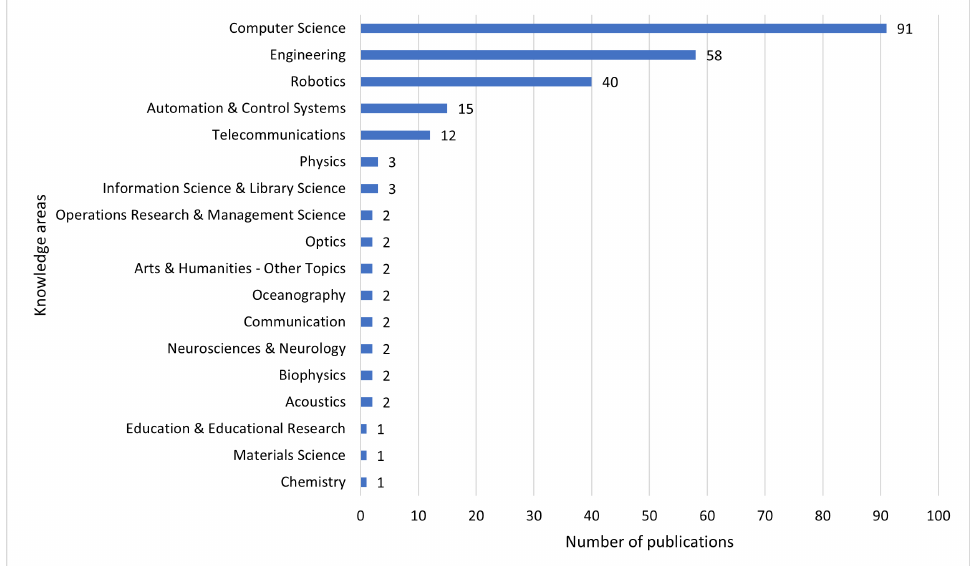
repeated are: augmented reality; wearable computing; computer vision; human–robot interaction and mixed reality. In relation to the various areas of knowledge, it is clear that most of the articles selected are related to technology, of which the most relevant